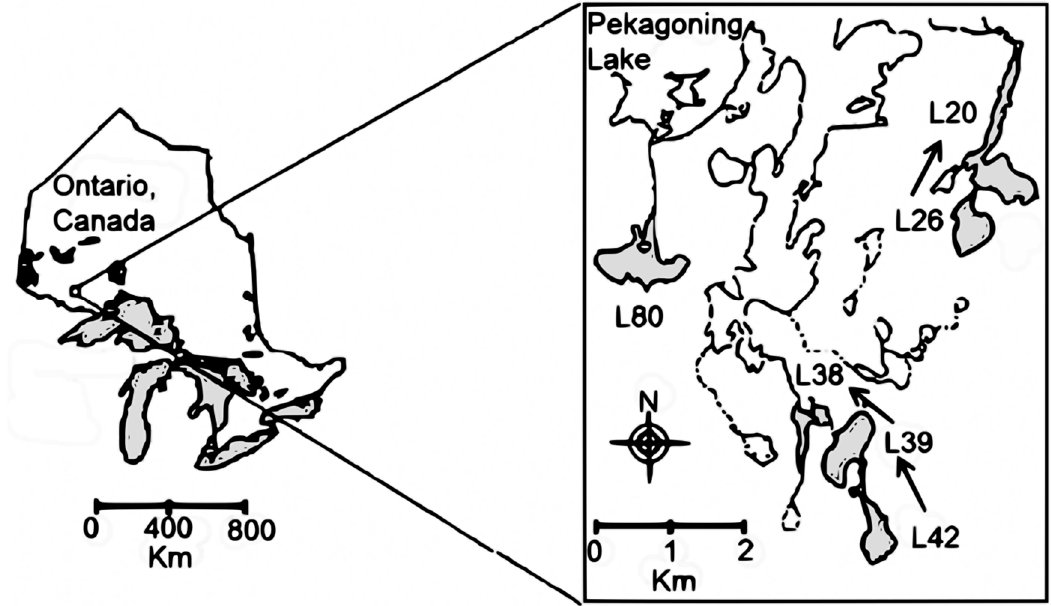
Figure 1. Location of the six monitored lakes within the Coldwater Lakes watersheds, in Ontario, Canada (undisturbed lakes: L20, L38, and L80; harvested lakes: L26, L39, and L42). Hydrological connectivity between lakes is indicated by